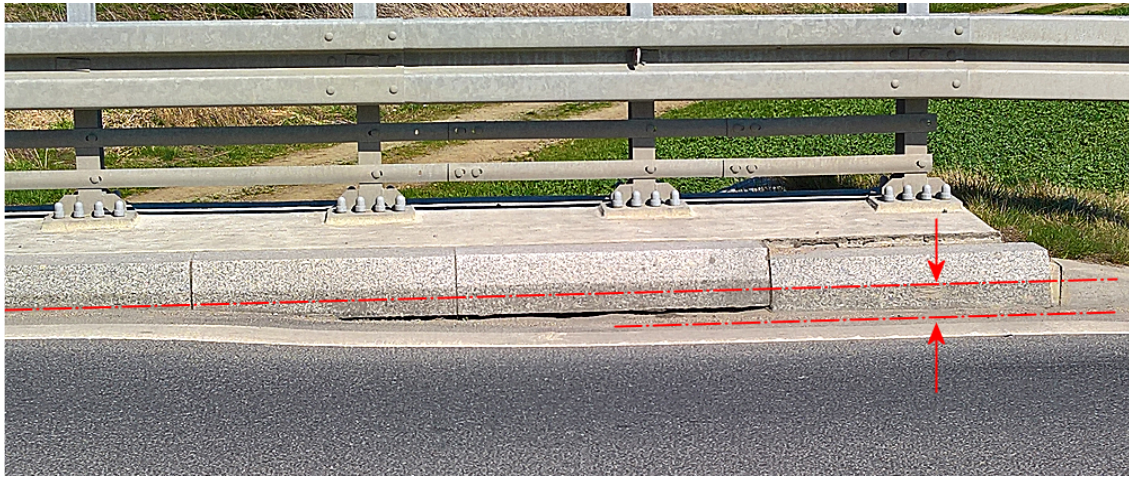
Figure 1: Settlements of the bridgehead on the road embankment transition